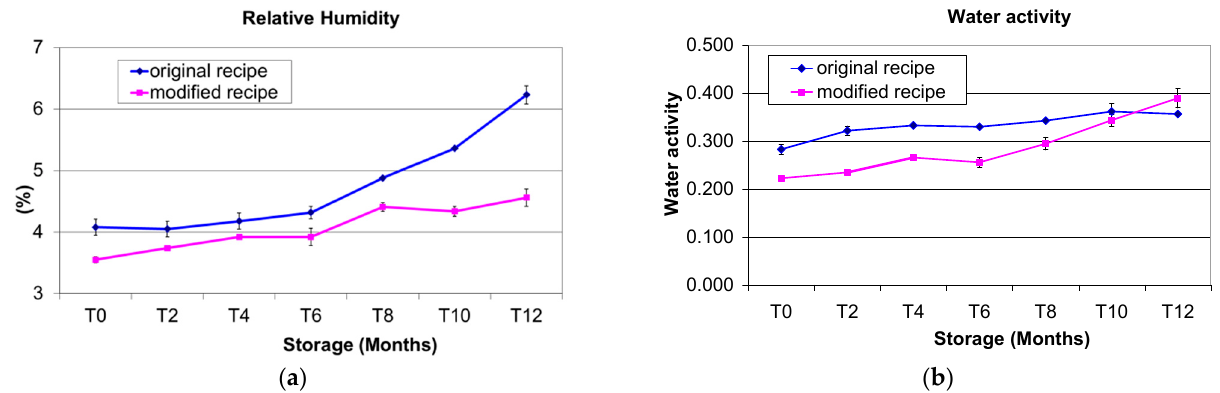
Figure 1. ( a ) Relative humidity of Italian Cantuccini biscuits prepared with the original recipe and the modified recipe during one year’s shelf-life. ( b ) Water activity of Italian Cantuccini biscuits prepared with the original recipe and the modified recipe during one year’s shelf-life.